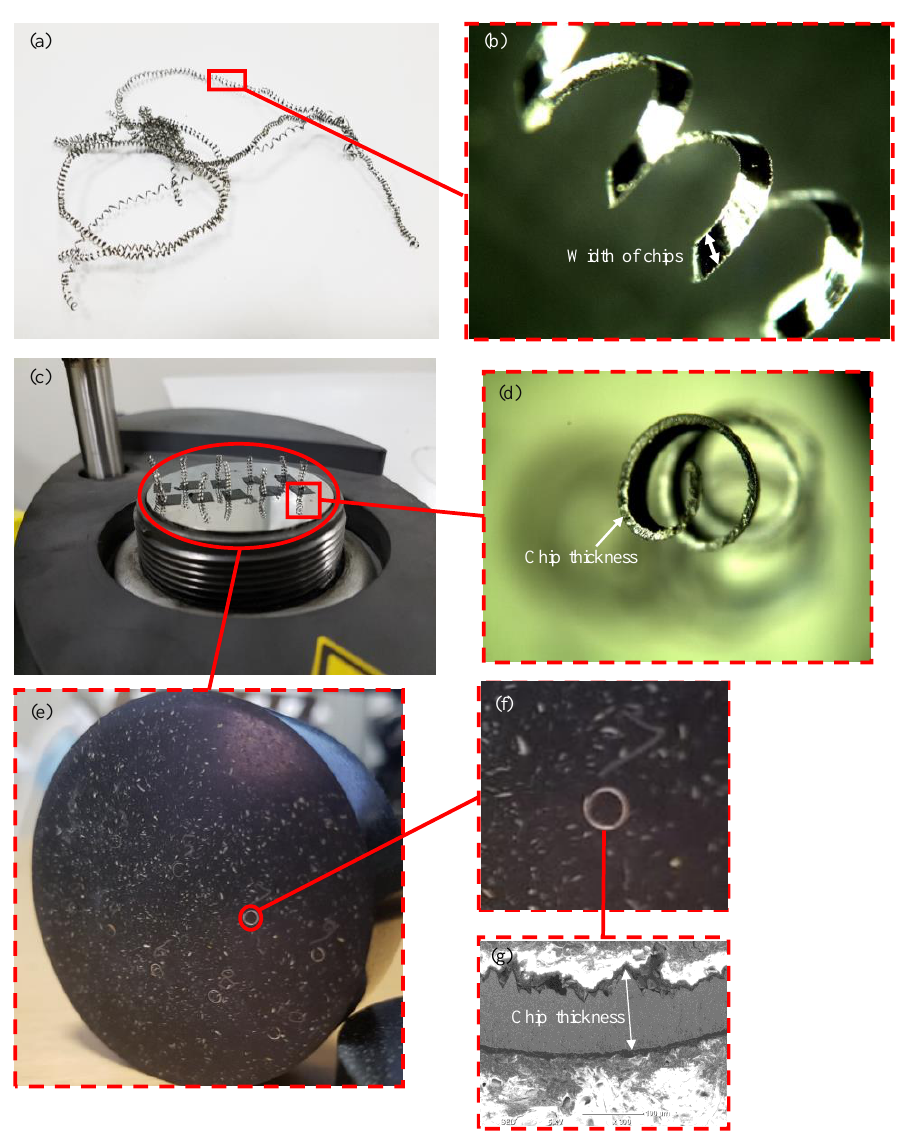
Figure 4. Steps of preparation for the chips to be measured by SEM.